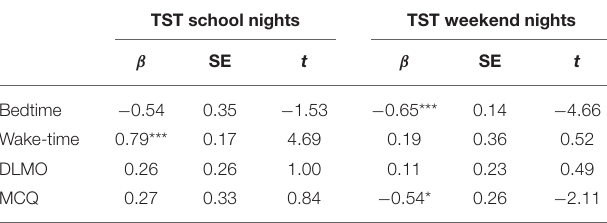
TABLE 4 | Predictors of sleep duration on school and weekend nights.